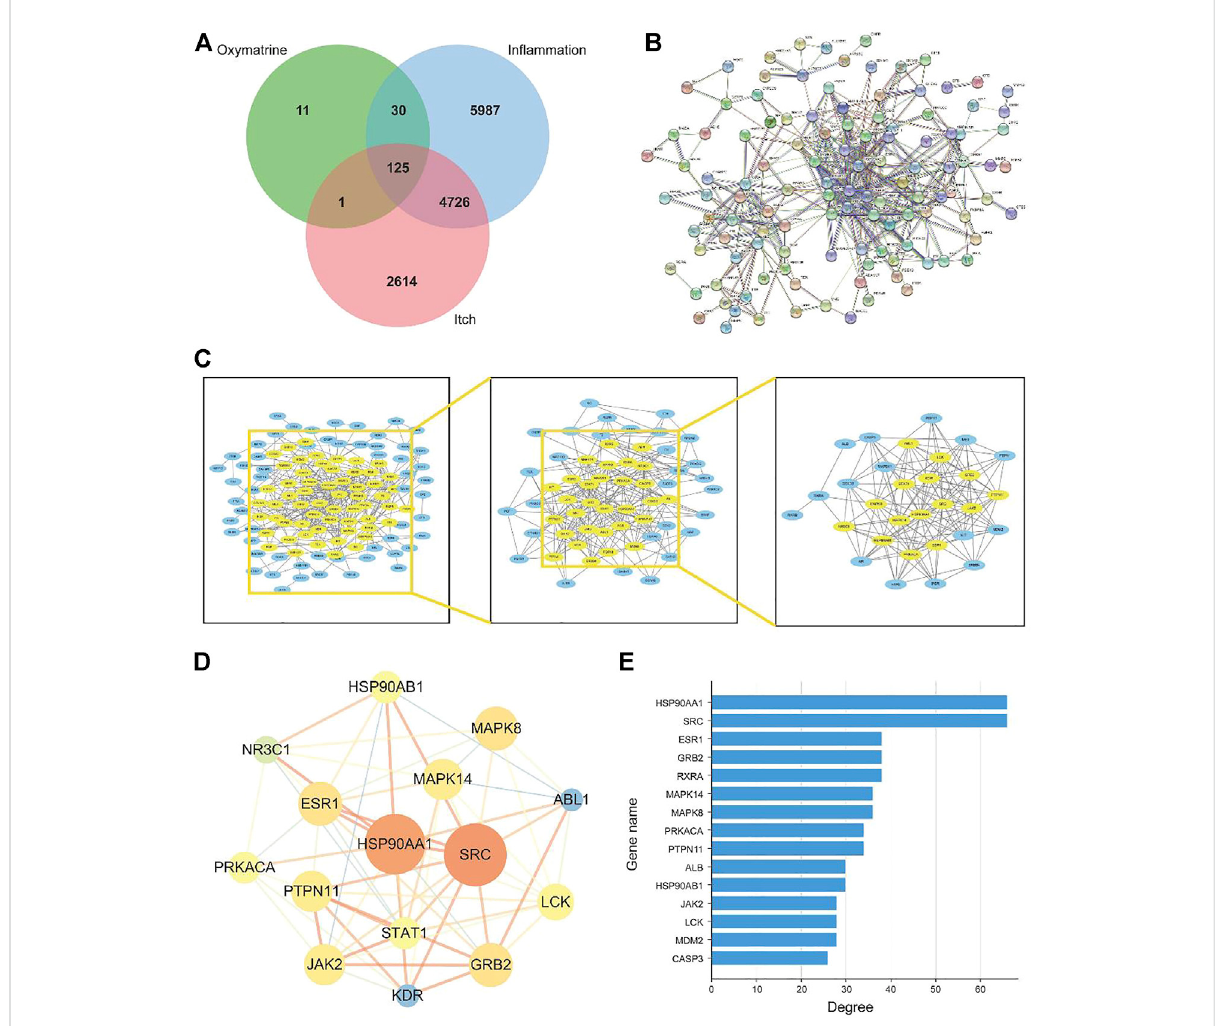
FIGURE 3 TheconstructionandanalysisoftheintersectiontargetsofOMT,in fl ammation,anditch. (A) VenndiagrammofOMT,itch,andin fl ammation (B) Protein-protein interaction (PPI) network of targets regulated by common targets of OMT, itch, and in fl ammation (C) Target network analysis diagram (D) IntersectiontargetnetworkdiagramgeneratedusingCytoscape. (E) TargetdegreevaluehistogramofcommontargetsofOMT,itch,and in fl